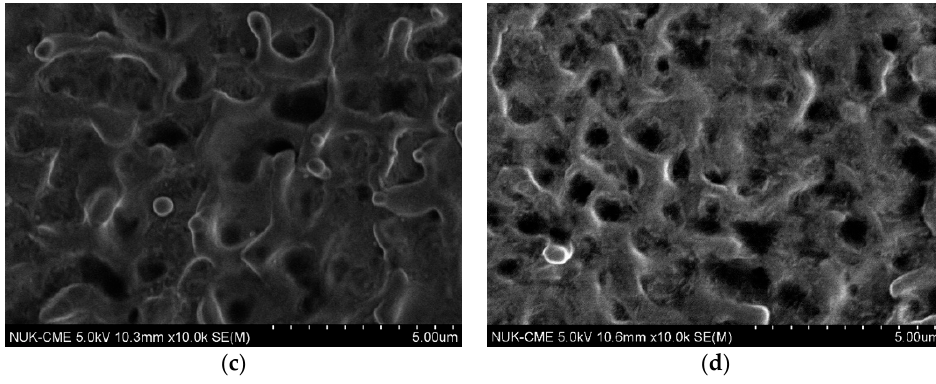
Figure 9. SEM at 10,000× when the speed of the cathodic specimen was ( a ) 0.0625, ( b ) 0.125, ( c ) 0.25, and ( d ) 0.375 mm/s, for the fixed electrode distance of 20 mm and applied voltage of 220 V.